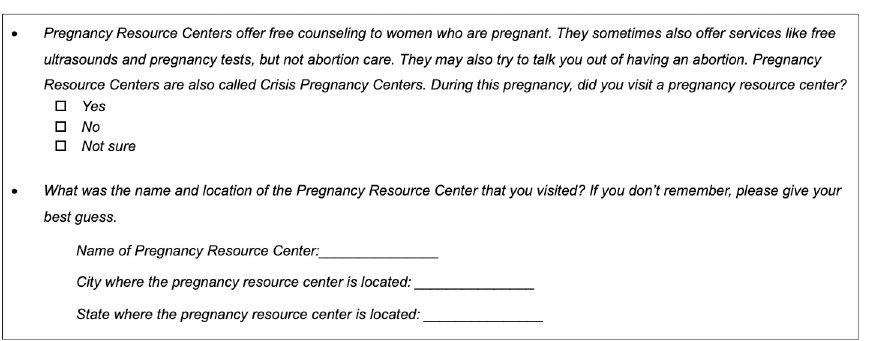
Fig 1. CPC questions in Google Ads Abortion Access Study 4-week follow-up